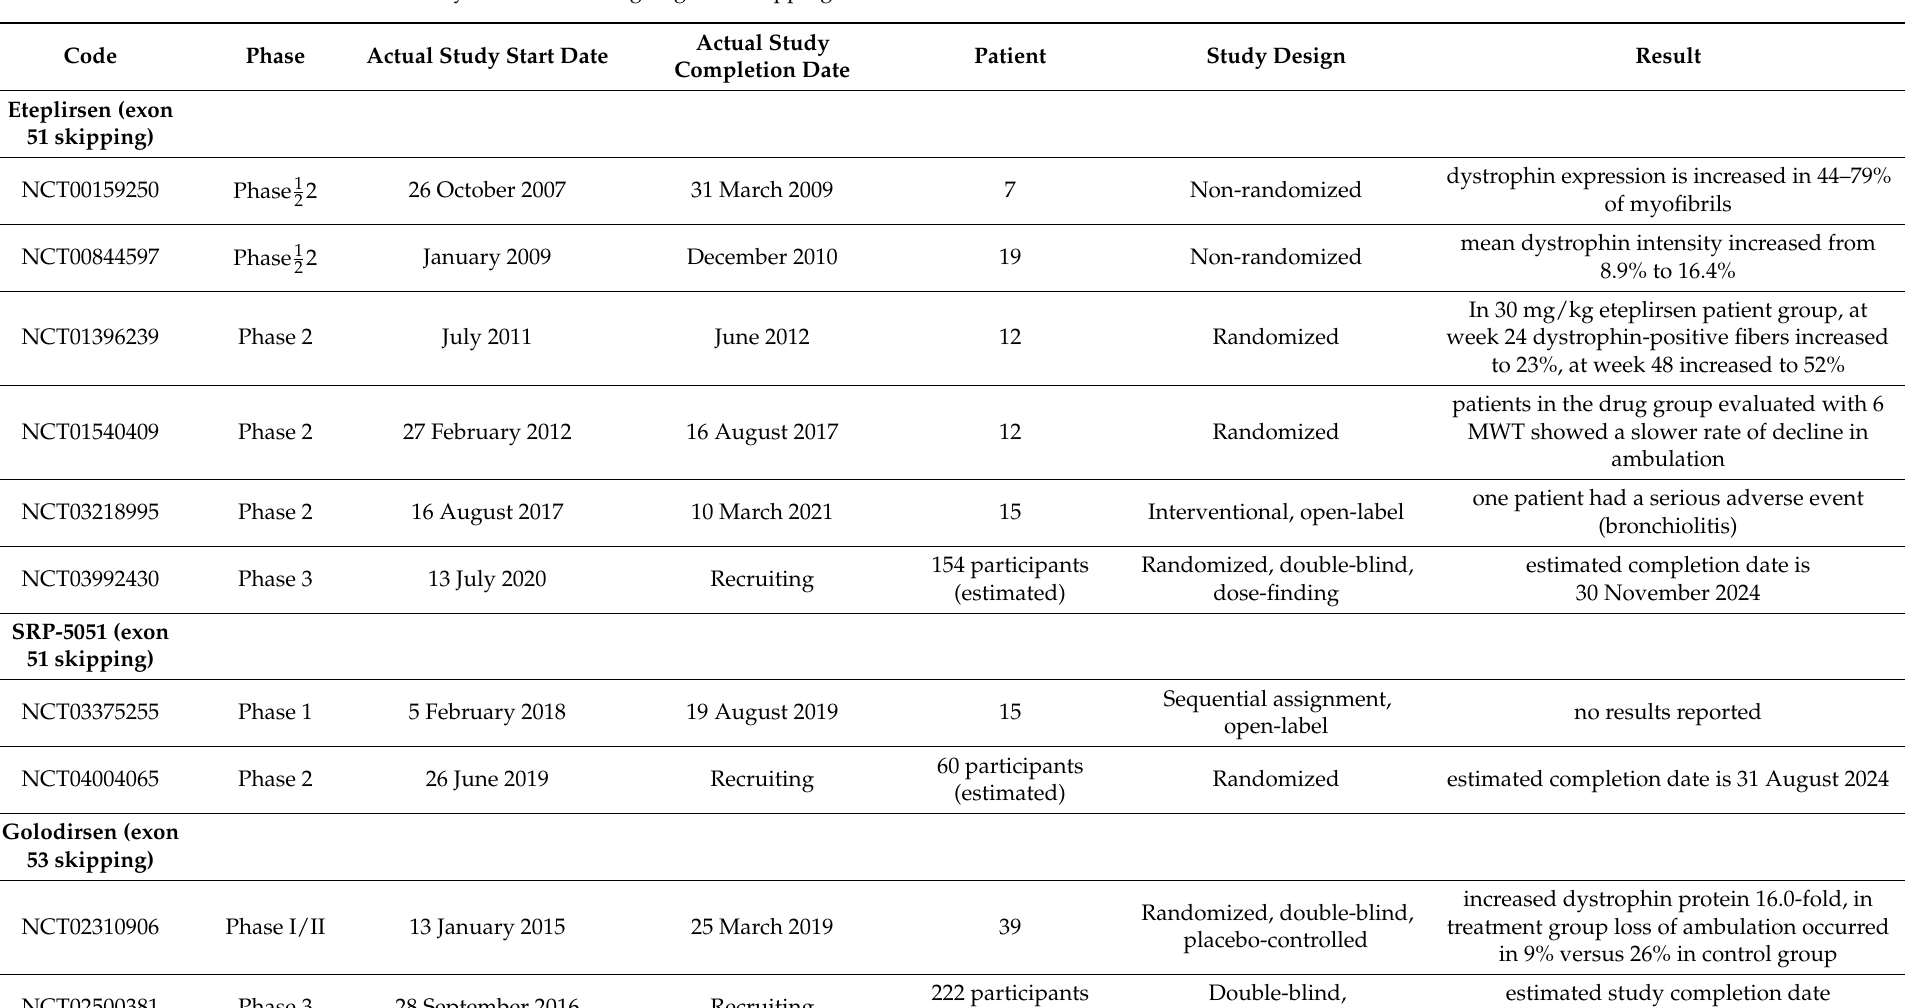
Table 2. History of active and ongoing exon skipping